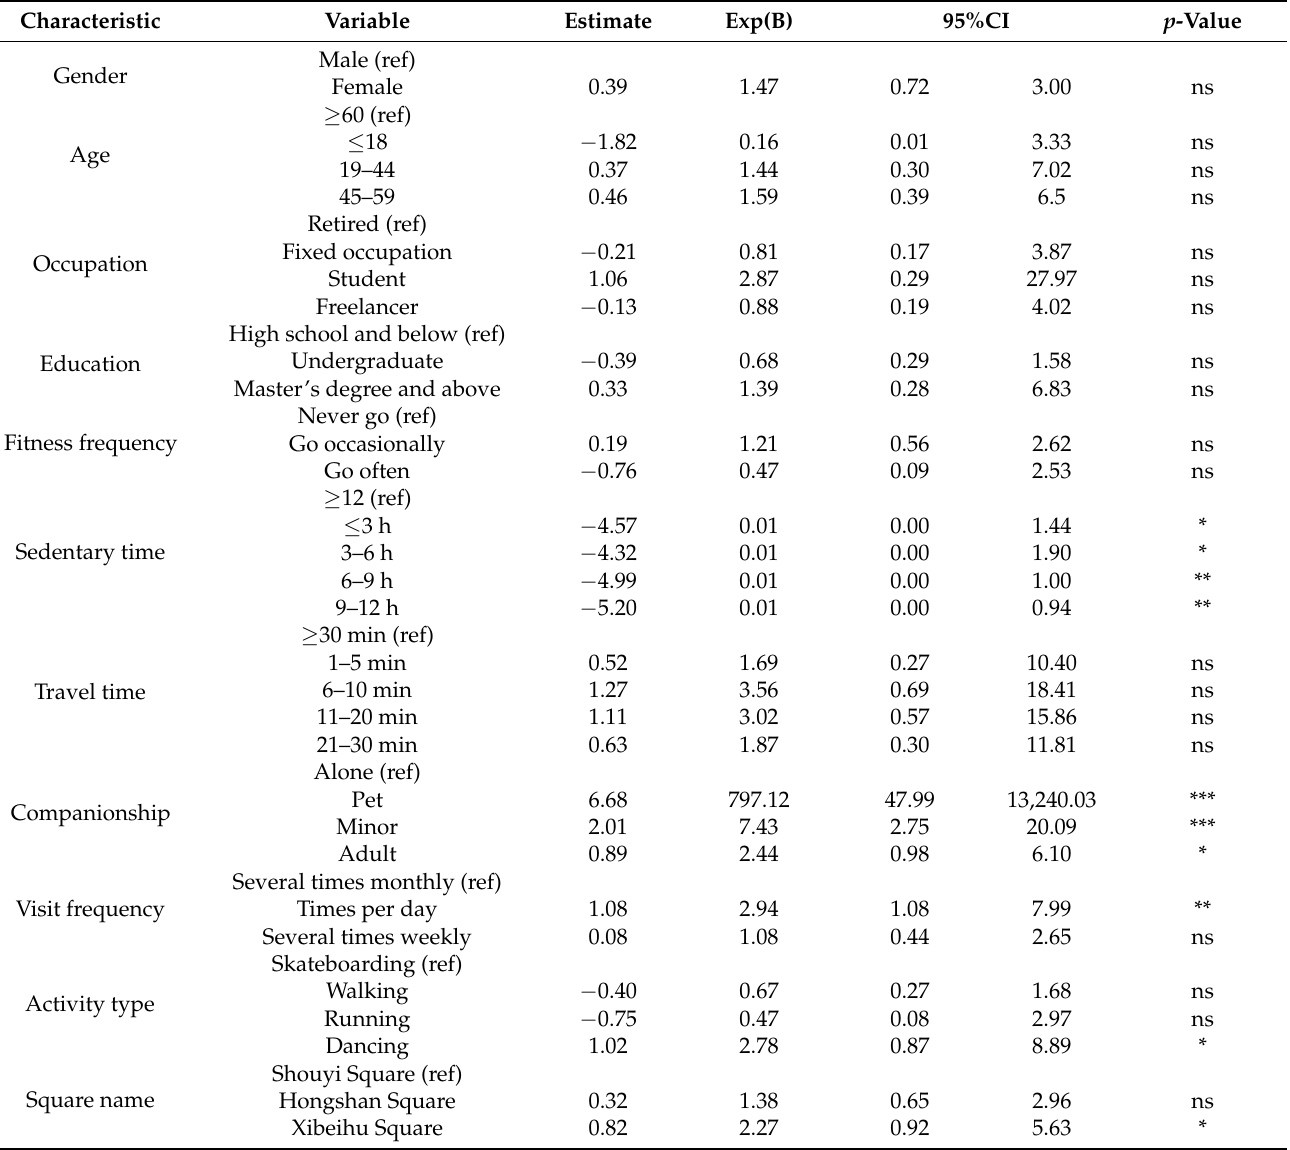
Table 5. Ordinal logistic regression analysis on the influencing factors of physical activity